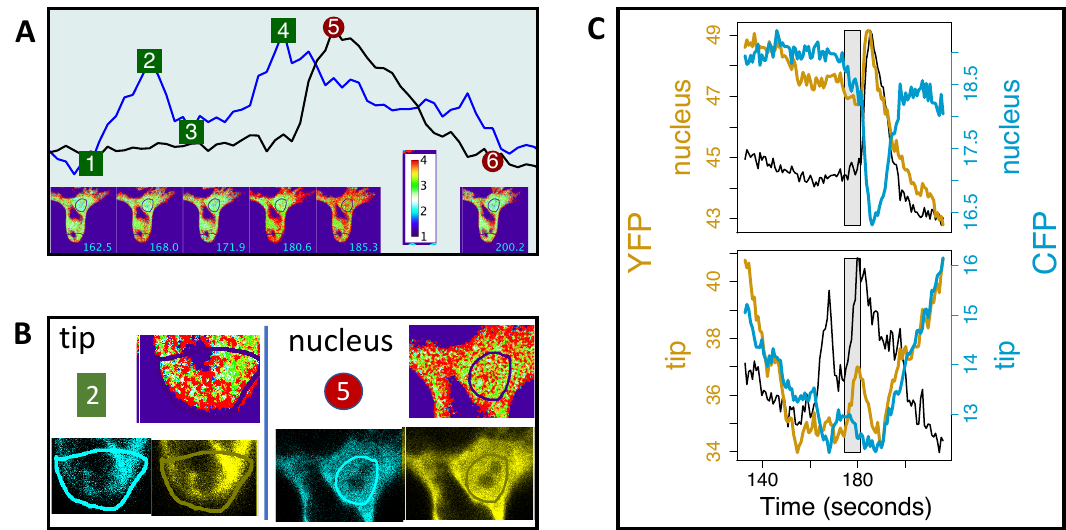
Figure 7. Increases in the ratio YFP/CFP may be caused by noise, more so in the apparent precursor apical Ca 2 + spike. Panel ( A ) shows the second (before t = 200 s) perinuclear Ca 2 + spike (black), superimposed on the corresponding apparent double apical Ca 2 + spike (blue). Panel ( B ) shows a snapshot of the YFP, CFP and ratio images at the time of the first apical peak ( t = 168.0 s, 2) and of the perinuclear spike ( t = 185.3 s, 4): large intensity (red) in the apical ratio image happens at pixels where the apical YFP and CFP images hardly show any signal. Panel ( C ) shows coincidences (grey polygon) between changes in parallel and antiparallel CFP (cyan) and YFP (gold colour) intensities. Data were recorded every 0.79 s, and the Ca 2 + sensor was the cytosolic/nuclear-localised